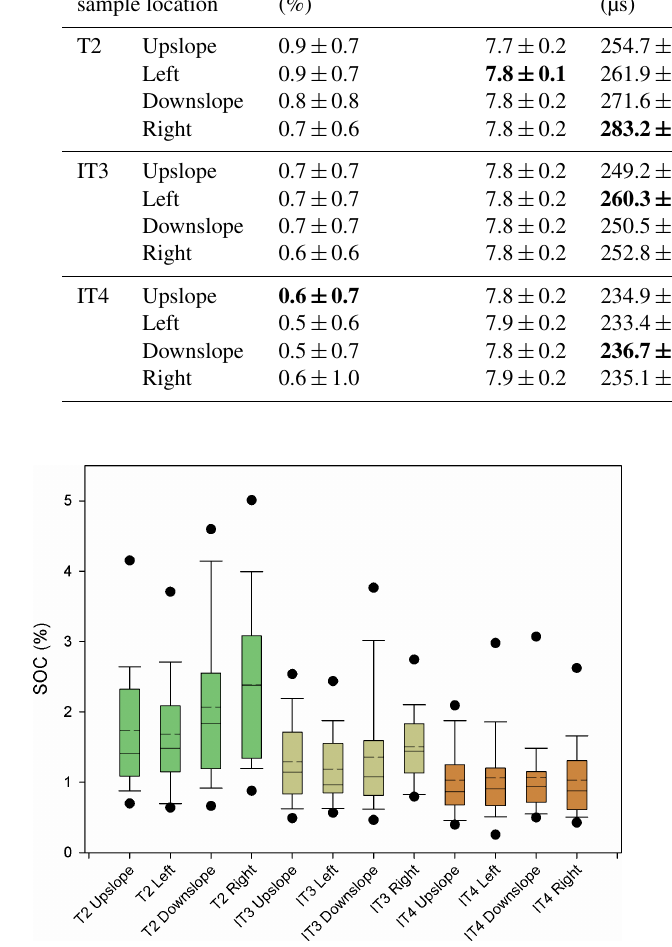
Figure 8. Box plots showing the content of soil organic carbon (SOC) values for slope positions upslope, left of the tree looking upslope, downslope and right of the tree looking upslope for sam- pling locations T2 (near tree drip line; within tree area), IT3 (near tree drip line; outside tree area) and IT4 (intertree area between two trees). Median – solid line; mean – dashed line; dots – 5th and 95th